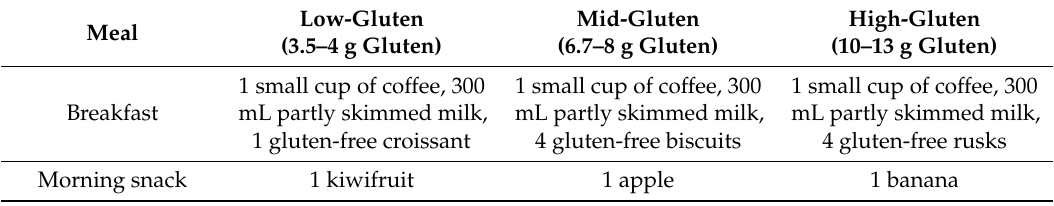
Figure 1. Flow-chart of the patients’ activity in the study. Two patients (drop-outs) decided to abandon Figure 1. Flow- chart of the patients’ activity in the study. Two patients (drop -outs) decided to the diet during the first week of intervention; GFD: gluten-free diet. abandon the diet during the first week of intervention; GFD: gluten-free diet. Table 2. Example of the three dietary plans used and differing in the amount of gluten contained 1